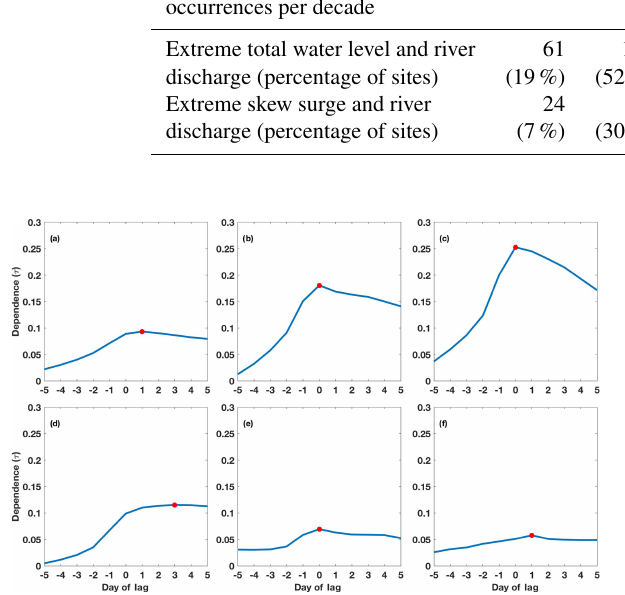
Figure 5. Kendall’s rank correlation τ plotted against day of lag at the follow sites: (a) Bournemouth [2], (b) Devonport [5], (c) Work- ington [18], (d) Ullapool [24], (e) Whitby [30], and (f) Cromer [32]. The red dot shows the day with maximum